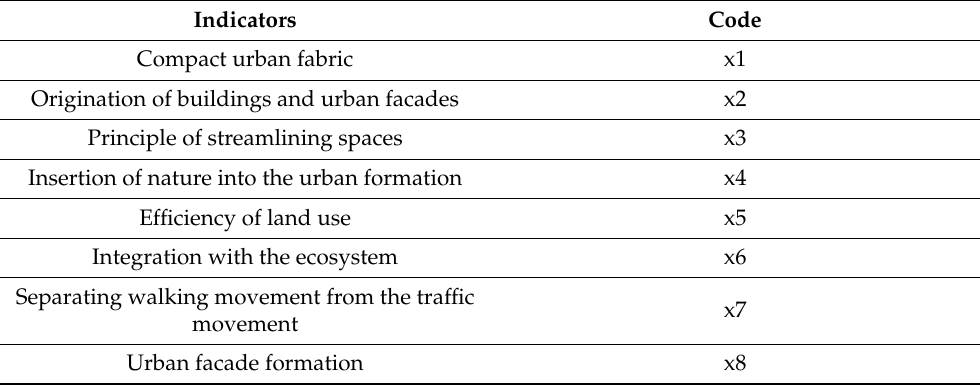
Table 3. Coding of sustainability indicators to facilitate their use in quantitative analysis strategies.